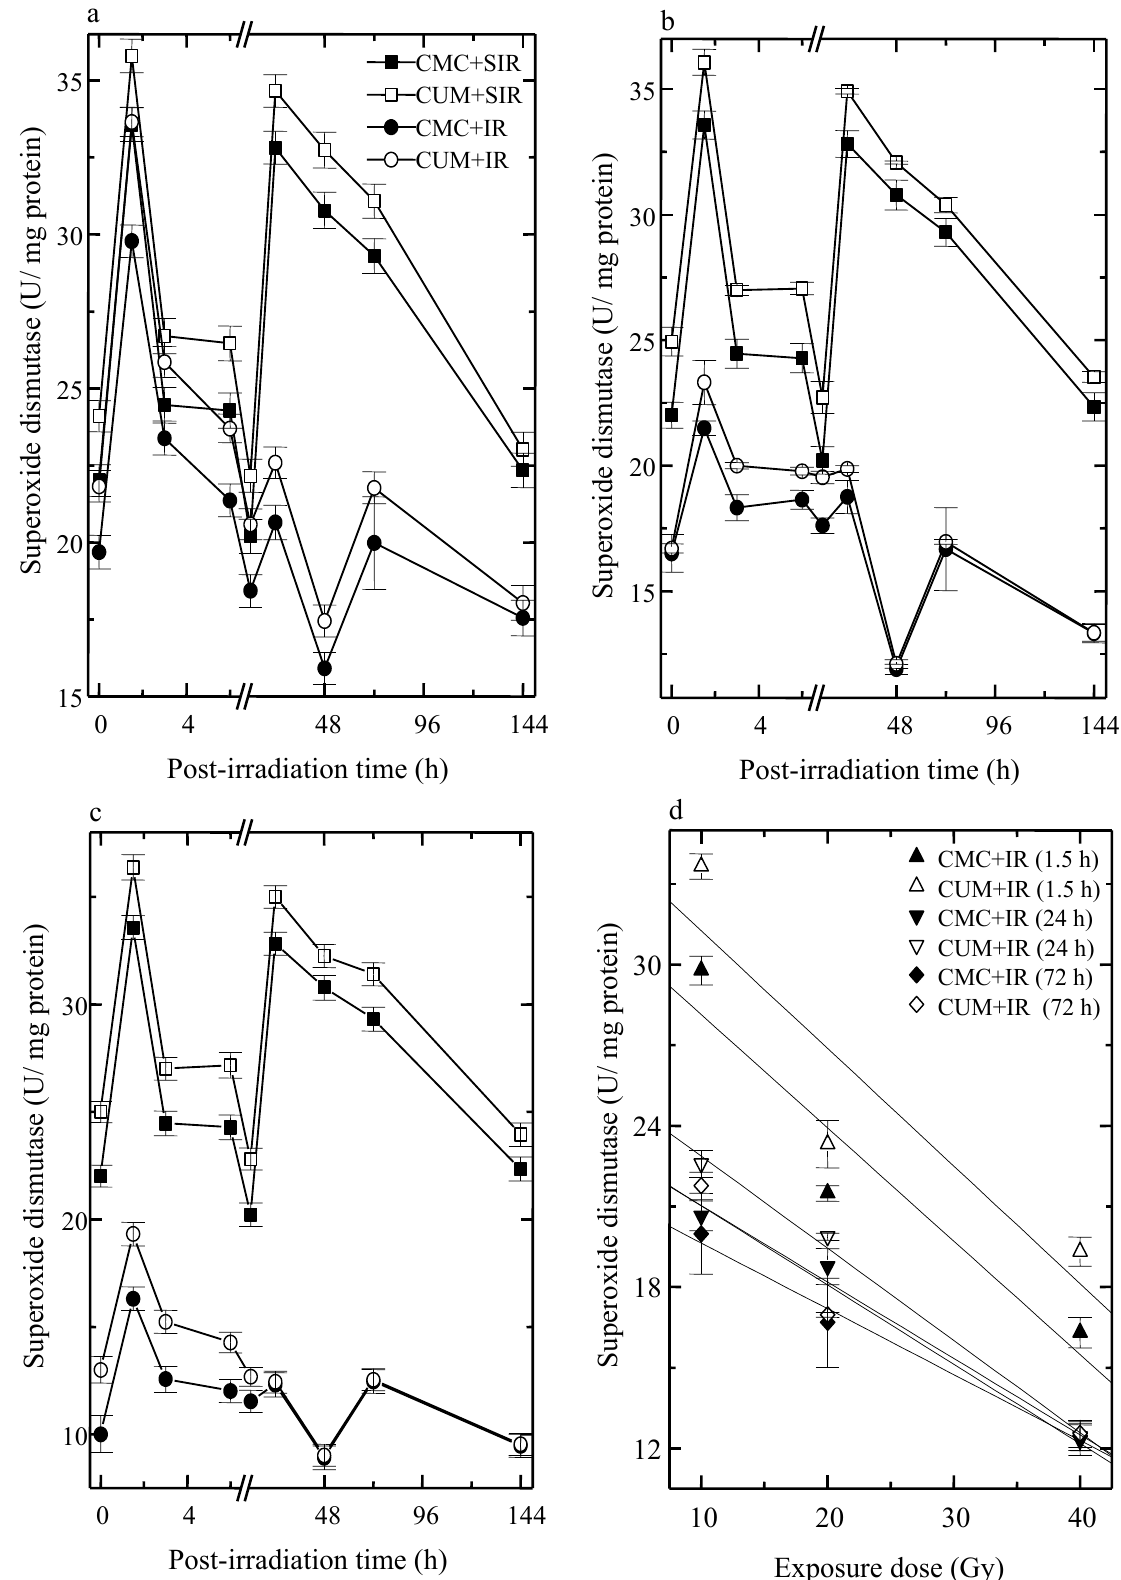
Figure 3. Effect of curcumin on superoxide dismutase activity in the skin of mice exposed to fractionated doses of fractionated γ-radiation. ( a ) 10 Gy ( b ) 20 Gy ( c ) 40 Gy and ( d ) dose response